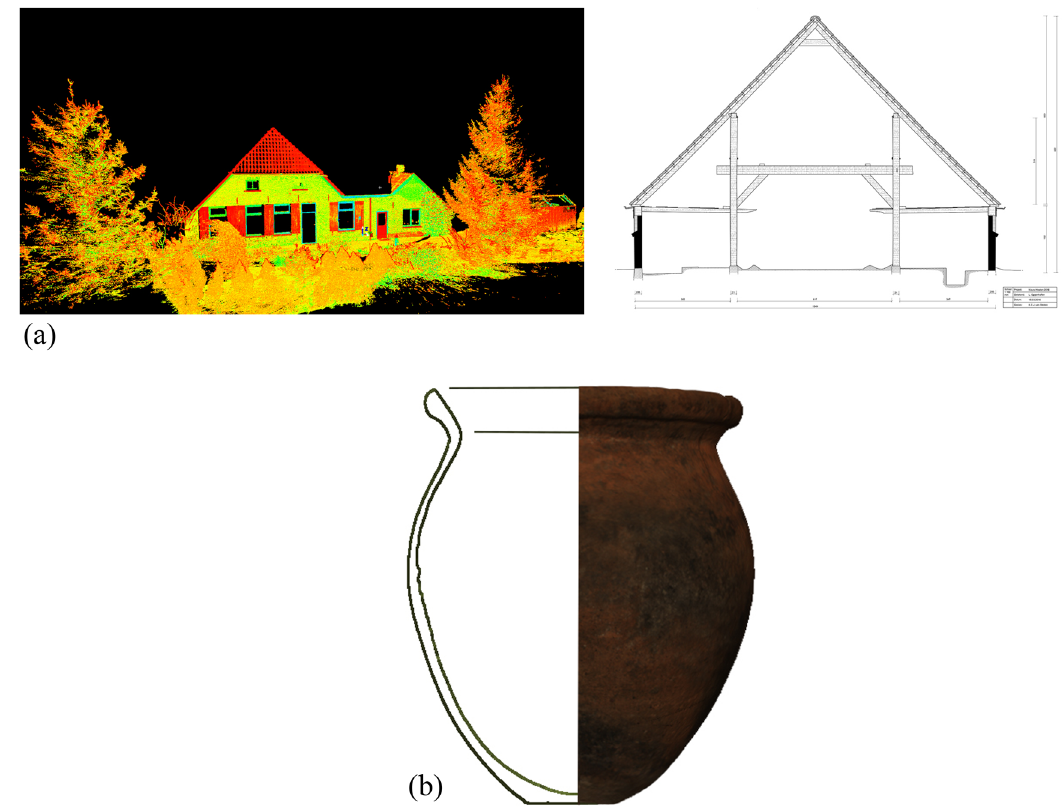
Figure 8: ( a ) Pointcloud of a farmstead ( scanned with a Leica P30 by M.H. Sepers ) and a CAD drawing based on a section of that pointcloud ( image by the author ) , ( b ) 3D scanned pot and an automatically generated section drawing ( scanning and image by the author ) . Same visual outputs, yet completely digital work fl